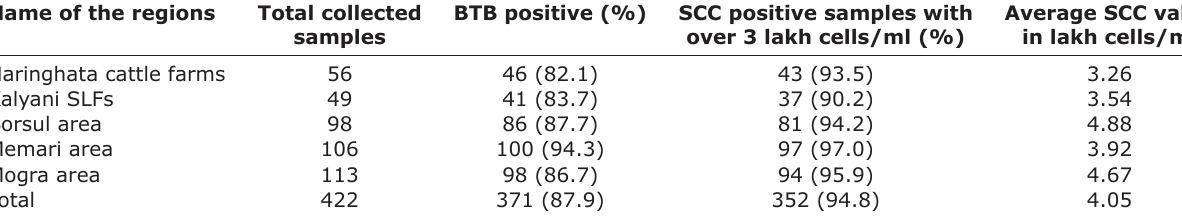
Table-1: Distribution pattern of positive samples in different farms/regions. Name of the regions